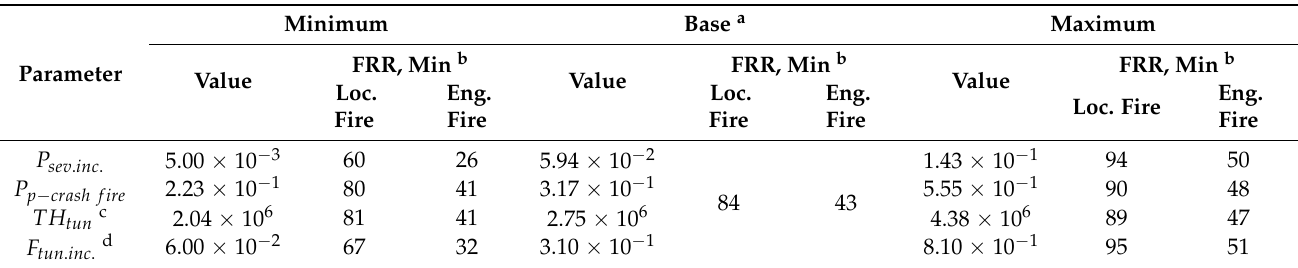
Table 5. Sensitivity analysis for selected input